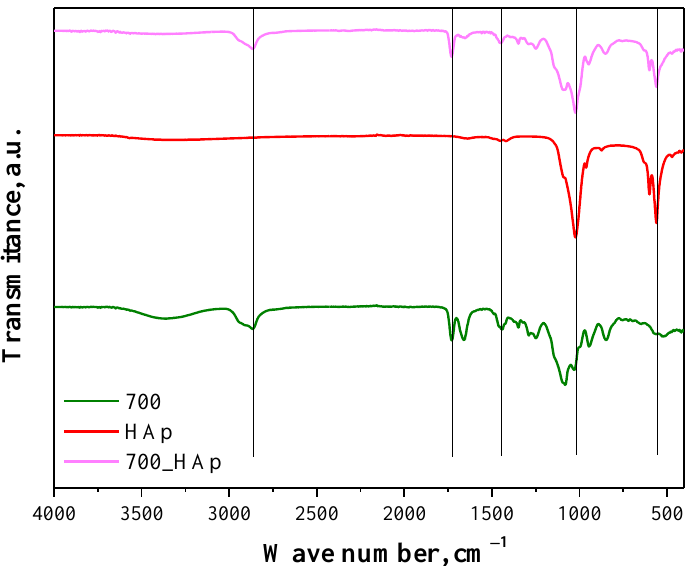
Figure 7. FT-IR spectrum of HAp (red), polymer matrix obtained using PEGDA 700 (700, green) and the composite obtained using the same crosslinker (700_HAp; pink).